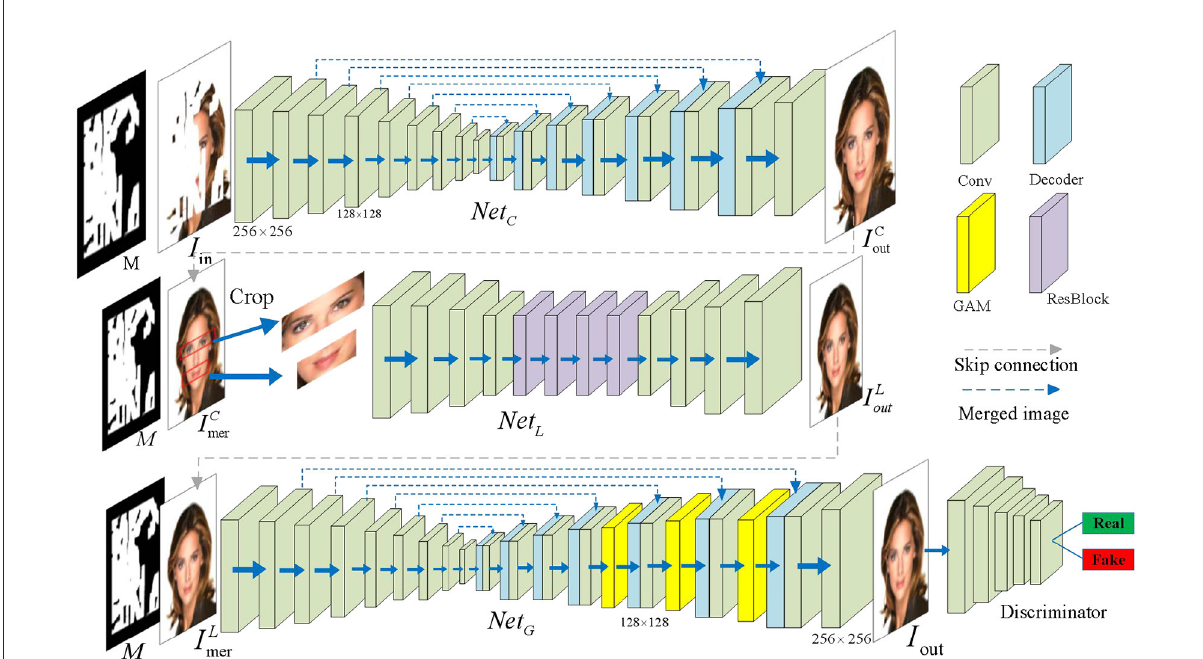
FIGURE4 The network architecture of our proposed method CLGN. The purple block in the local development network indicates a two-layer residual block (He et al., 2016). The three yellow blocks represent the GAM attention modules with resolutions of 16 × 16, 32 × 32, and 64 × 64, respectively. The green blocks represent the convolutional layer and the blue blocks represent the decoder. The face images are adapted from the celeba-HQ dataset, which comes from Karras et al.